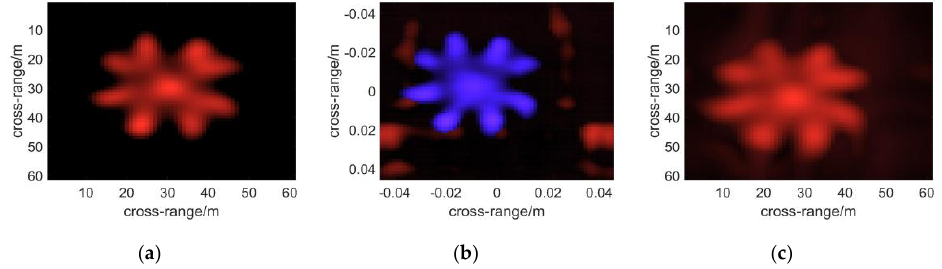
Figure 13. 3-D reflectivity figures by: ( a ) BPA; ( b ) RMA; ( c ) PMA. The brightness of each pixel represents the maximum modulus of the complex voxels along the range direction, while the color, which ranges from red to blue with increasing distance, of each pixel indicates the position where the maximum modulus is situated.